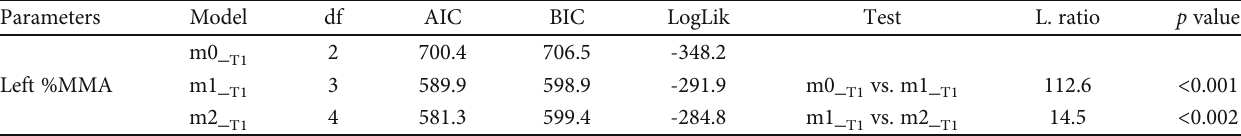
Table 2: FIT-SAT treatment e ffi ciency: best fi t mixed-e ff ect models (unilateral smile in T1).